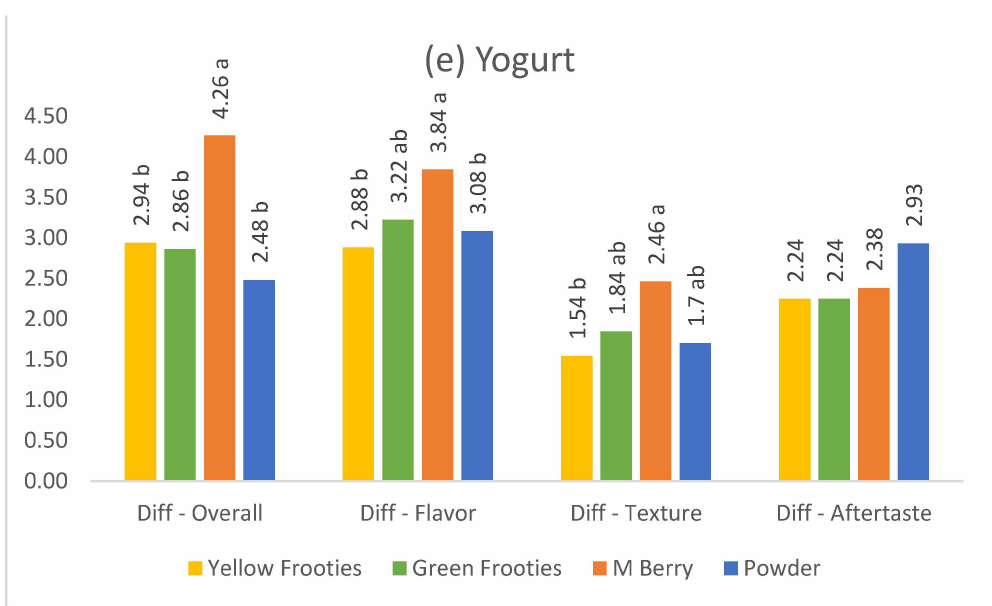
Figure 2. Means of the difference between pre and post-test liking intensity for food samples, ( a ) apple, ( b ) goat cheese, ( c ) lemonade, ( d ) pickle, and ( e ) yogurt on miracle fruit products (Yellow Frooties—Y, Green Frooties—G, M Berry—M, and Powder—P, product details given in Table 1). Means in the same liking attribute labeled with the same letter are not significant different (Tukey HSD test, p <